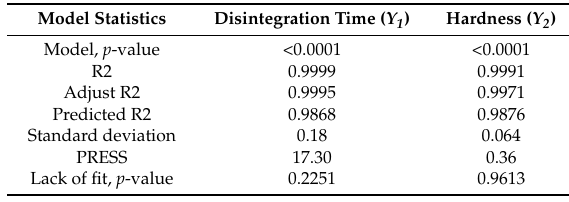
Table 3. Summary statistics for reduced special cubic model for disintegration time and quadratic model for hardness in herbal tablets containing 50% of Wuzi Yanzong dry powder